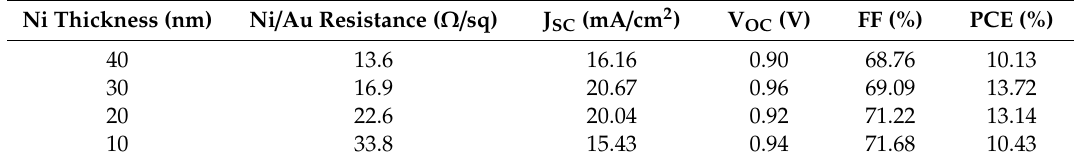
Table 1. Photovoltaic parameters of PSCs with various Ni(x nm) / Au (10 nm)